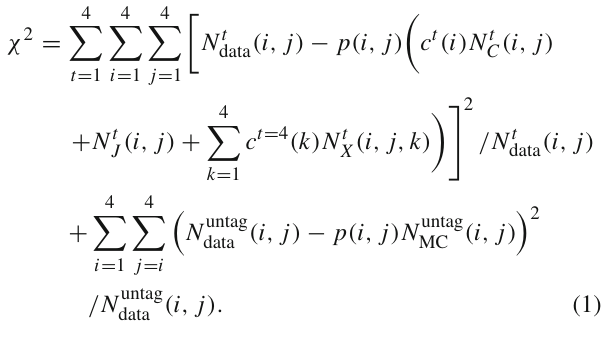
Table 2 The contributions to the c -jet pseudo-continuous mistagging efficiency scale factor systematic uncertainties for particle-flow jets. Listed are the uncertainties related to the t ¯ t modelling, the jets and E miss Tagging interval